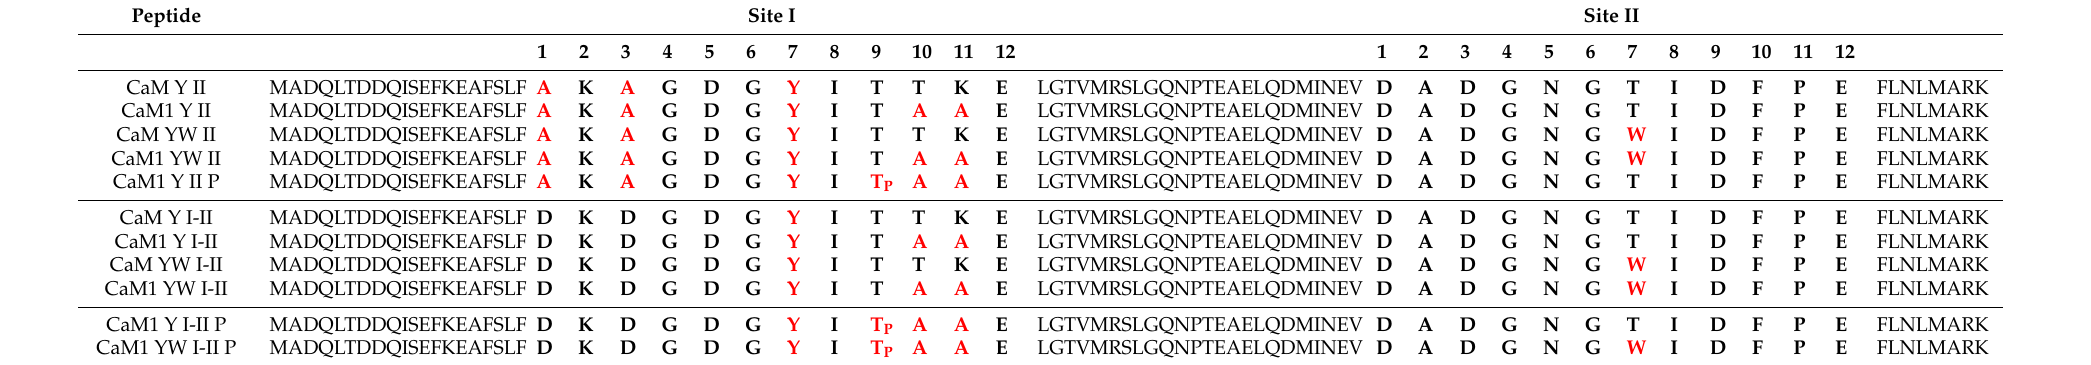
Table 1. Amino acid sequences for the investigated mutants of CaM N-ter domain. Modified residues compared with the wild type sequence are reported in red. Residues of the two metal-binding sites are highlighted in bold. Only the amino acids in each metal-binding loop are numbered, from 1 to 12. The first five peptides are impaired to bind UO 22+ at site I, while all the other variants are able to bind UO 22+ at both sites; variants named with a W present a tryptophan residue at position 7 of site II; all variants present a tyrosine residue at position 7 of site I. Variants with site I Thr9P are named with a P. Symbol T P represents a phosphorylated threonine